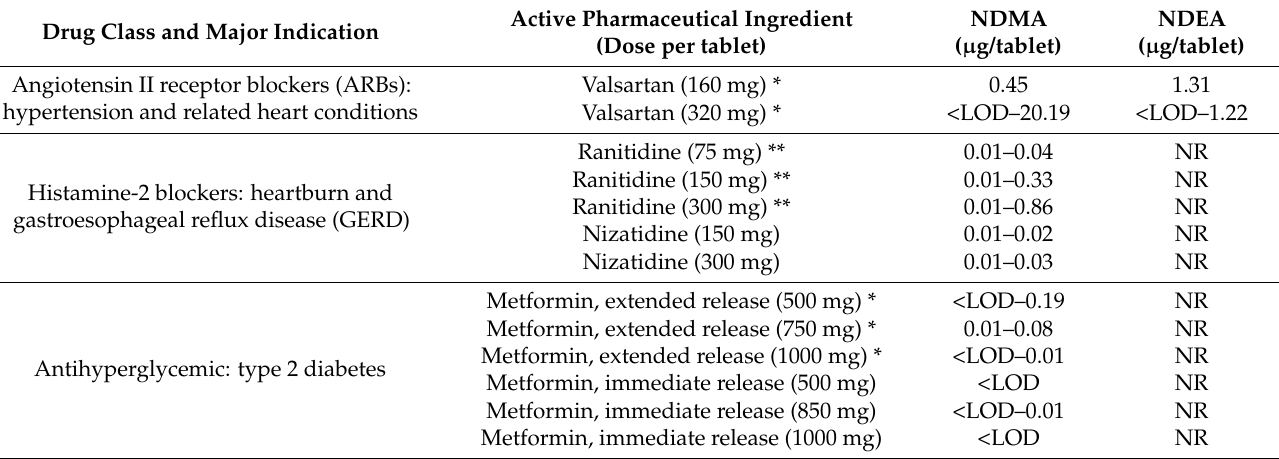
Table 4. Reported levels of nitrosamines in certain drug products (US FDA 1